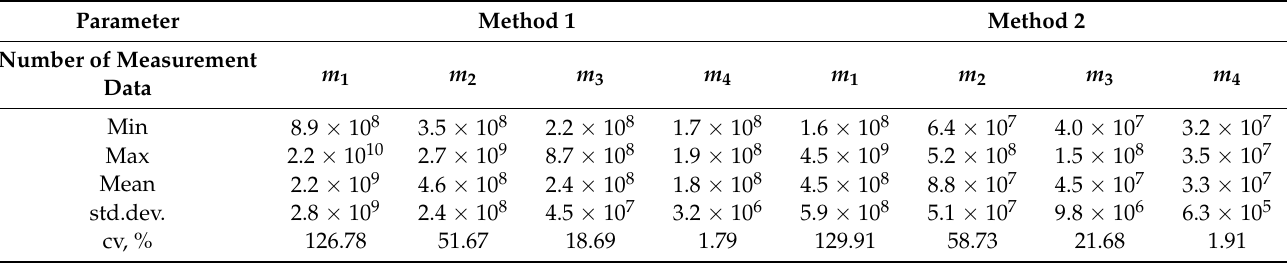
Table 3. Condition number cond ( G ) for load level V 0.5 .